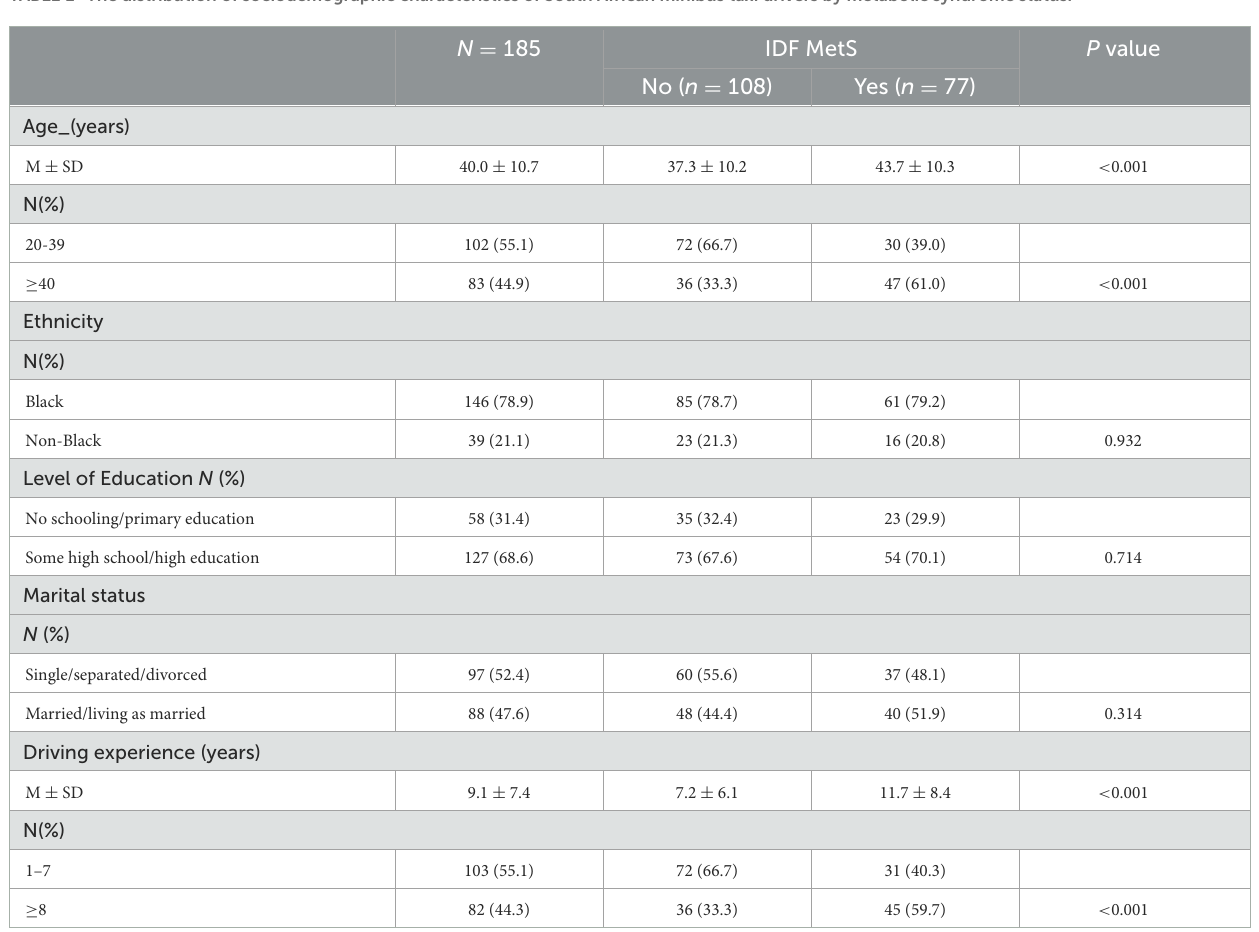
TABLE 1 The distribution of sociodemographic characteristics of South African minibus taxi drivers by metabolic syndrome